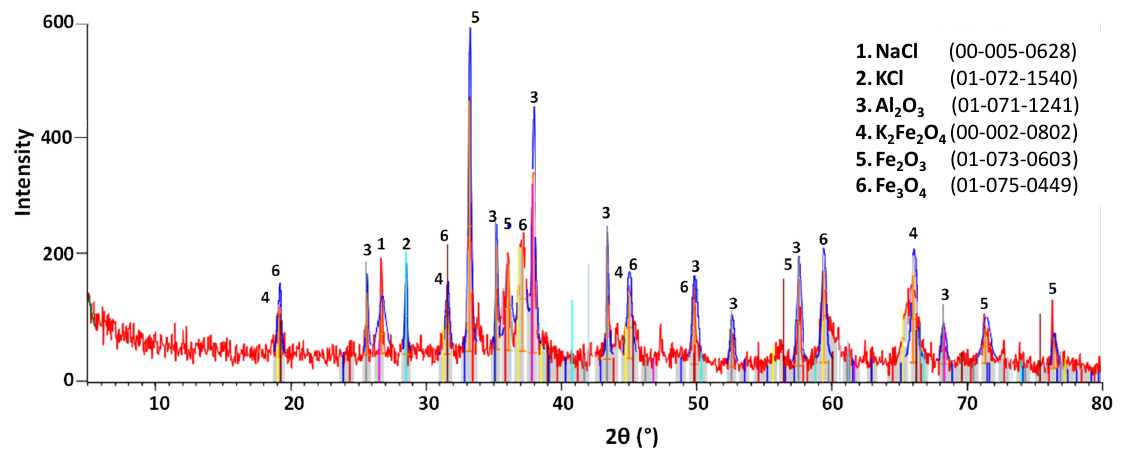
Figure 10. Mineralogical phases (XRD patterns) of salt slag after leaching.